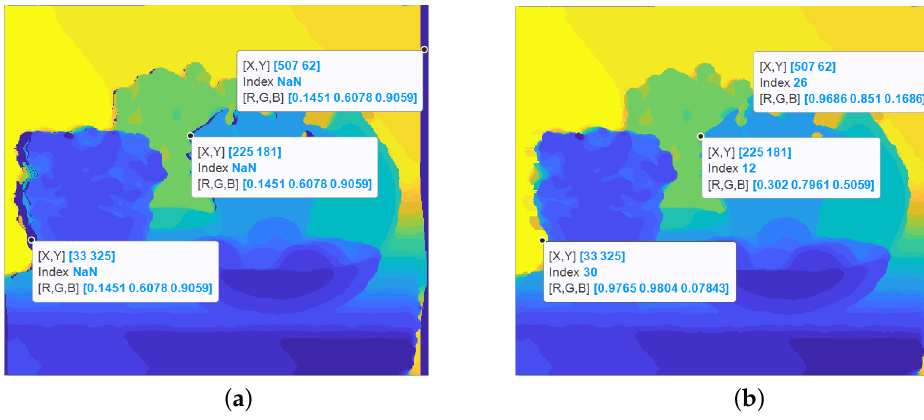
Figure 7. ( a ) Gaps generated in the depth image due to occlusion, and ( b ) Depth map after the gaps are